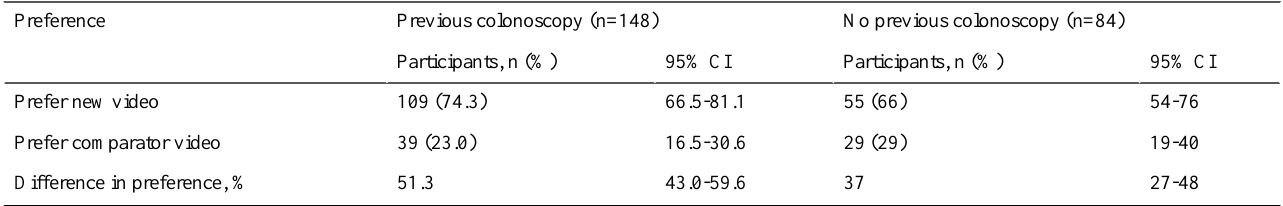
Table 3. Preferred video related to history of colonoscopy.